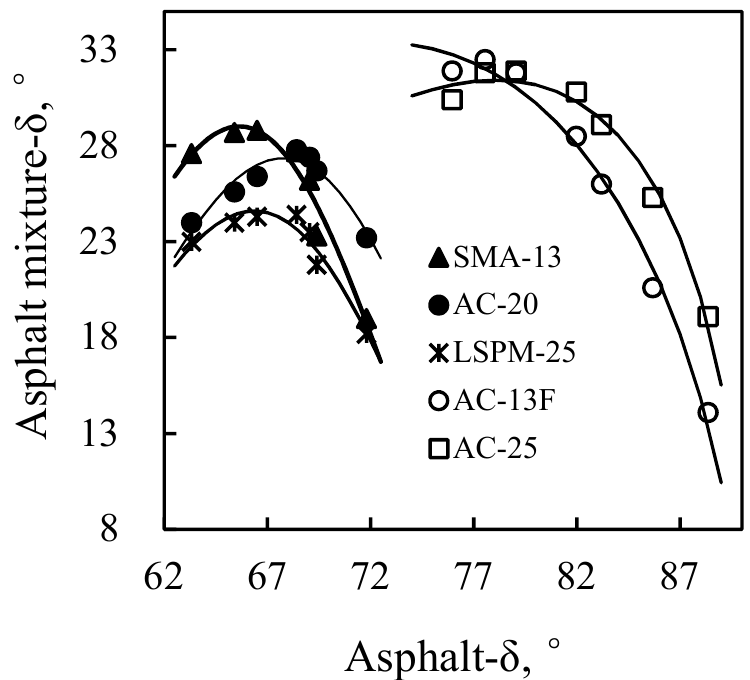
Figure 7. Phase angle relationship between asphalt and mixture.